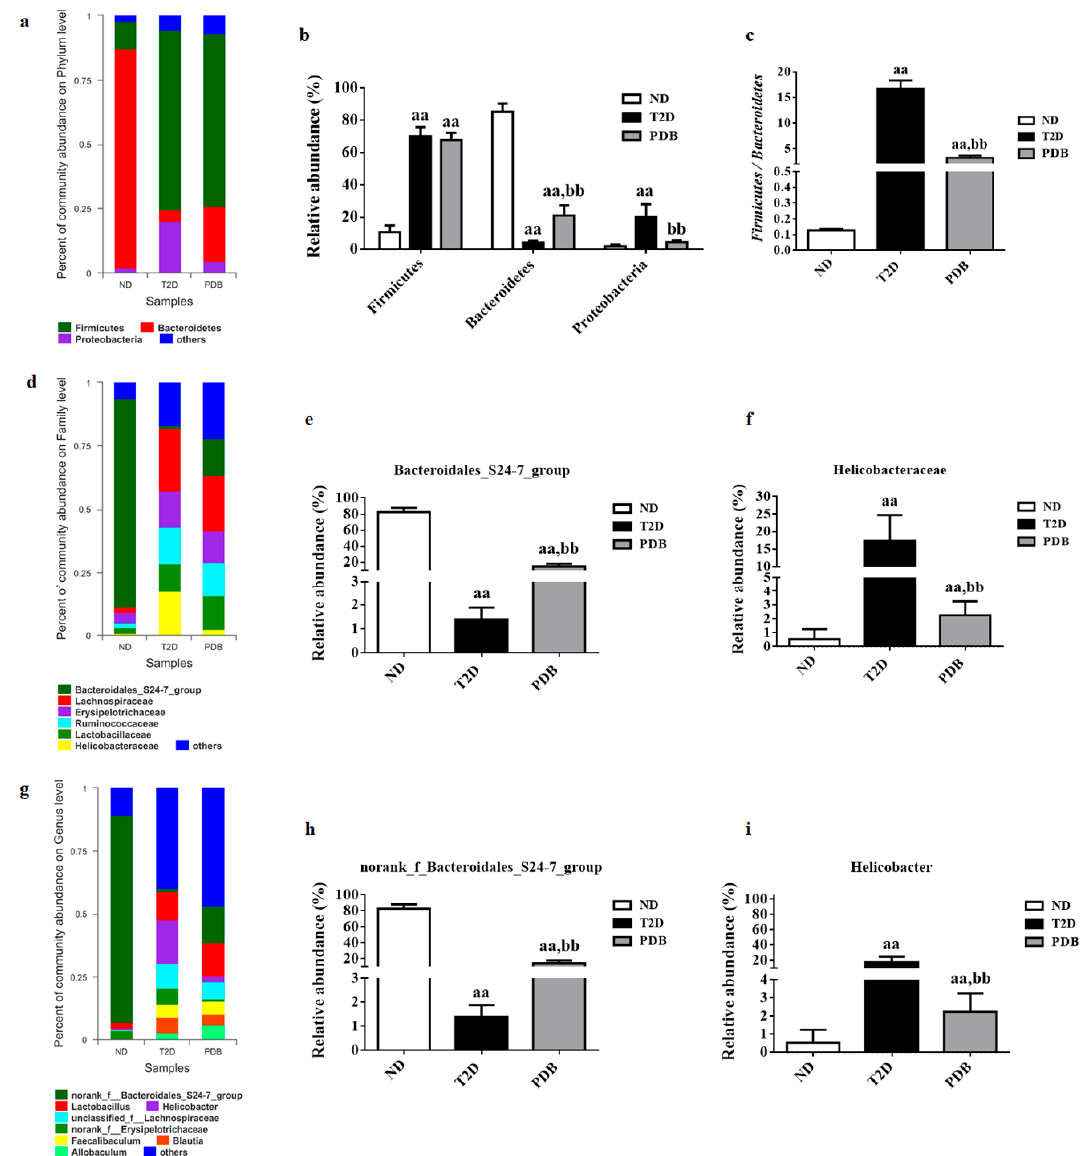
Figure 4. PDB changed gut microbiota composition of diabetic mice induced by HFD and STZ. Taxonomic distribution of bacterial communities of diabetic mice fecal samples at phylum level ( a ), family level ( d ) and genus level ( g ). The relative abundance of Firmicutes, Bacteroidetes, and Proteobacteria ( b ); The ratio of Firmicutes to Bacteroidetes ( c ); The relative abundance of Bacteroidales_S24-7_group ( e ), Helicobacteraceae ( f ), norank_f_Bacteroidales_S24-7_group ( h ), and Helicobacter ( i ). Data are presented as mean ± SD, n = 6. a p < 0.05, aa p < 0.01 versus the ND group. b p < 0.05, bb p < 0.01 versus the T2D